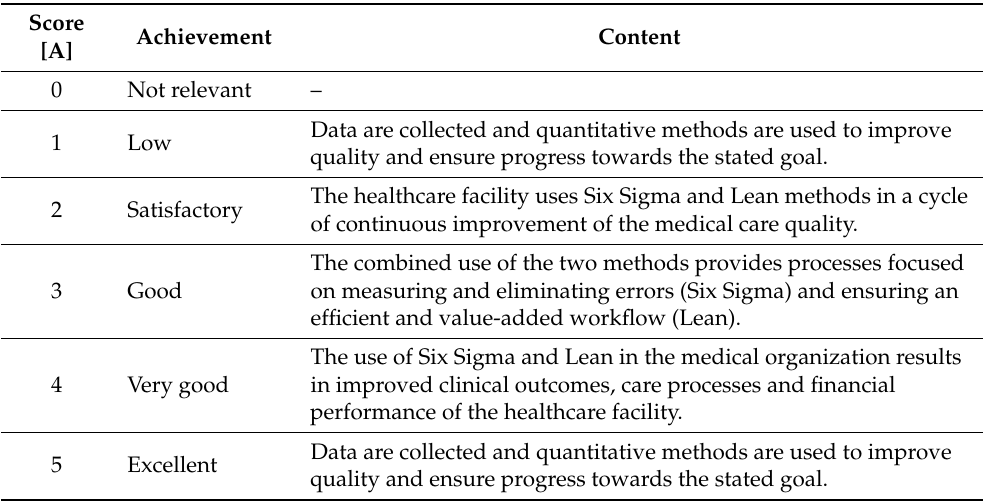
Table A18. Scale for indicator RB3—Medical organization supported by Six Sigma and